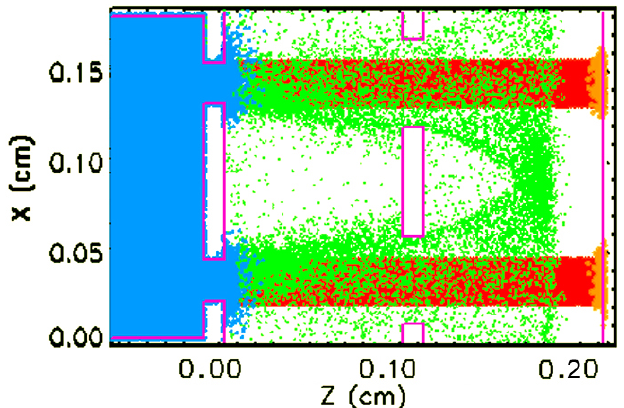
FIG. 3. (Color) Particle plot from an LSP simulation of the (cid:3) t (cid:4) (only a fraction of the pinhole Faraday cup diagnostic for I b total number of particles are plotted for clarity reasons): (red) K (cid:2) ion beam particles; (blue) plasma electron particles; (green) plasma ion particles; (orange) secondary electron particles. The grounded frontplate ( z (cid:5) 0 mm ), the negatively biased electron- repelling backplate ( z (cid:5) 1 mm ), and the positively biased col- lector cup ( z (cid:5) 2 mm ) are shown. Secondary electrons created by plasma ion bombardment on the backplate are not shown for clarity